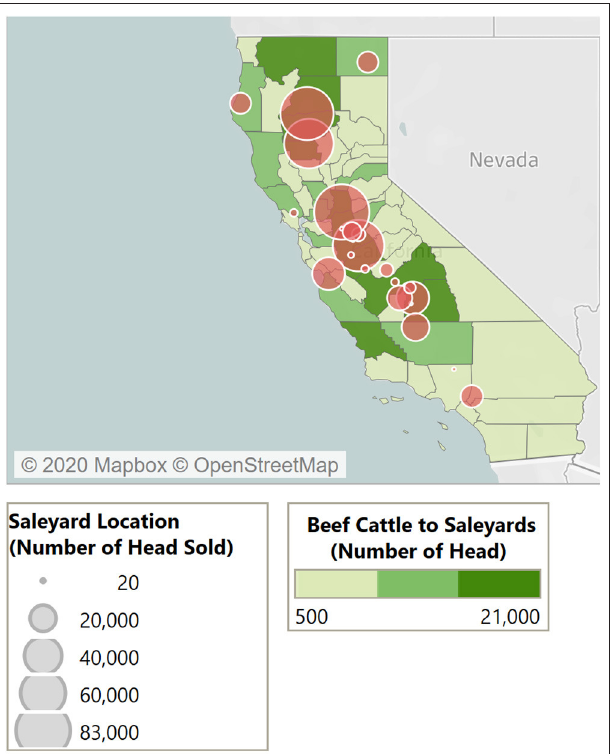
FIGURE 8 | Origin of all beef cattle from California (by county) sold at saleyards with location of sale yards and number of head sold in